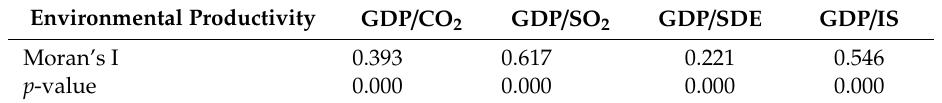
Table 4. Spatial autocorrelation Moran’s I of environmental productivity of Chinese urban agglomerations. Environmental